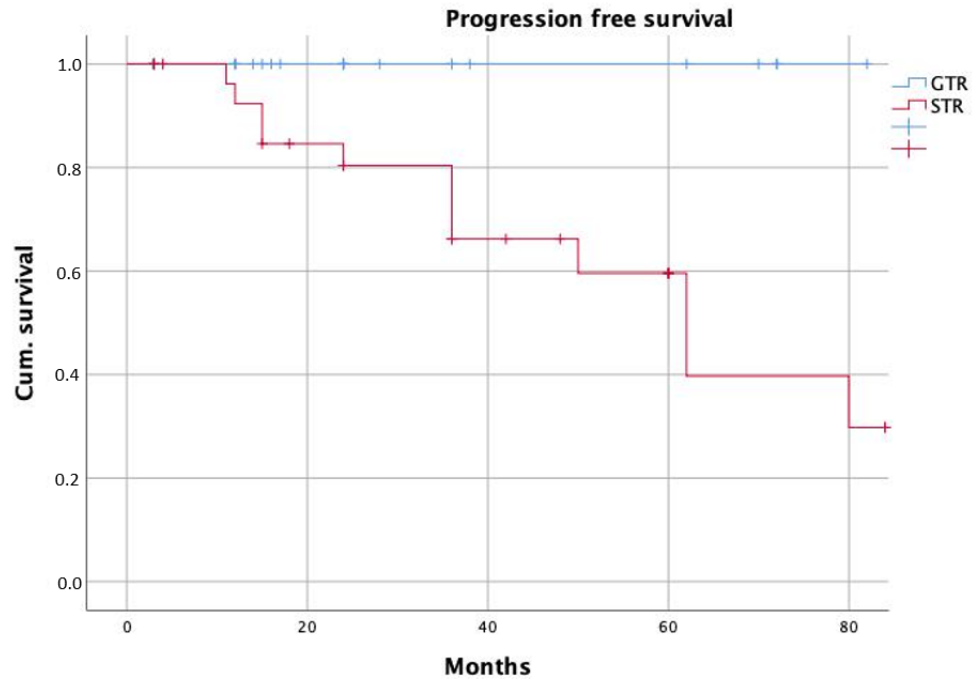
Figure 2. Progression-free survival according to the extent of resection (GTR—gross total resection; STR—subtotal resection).